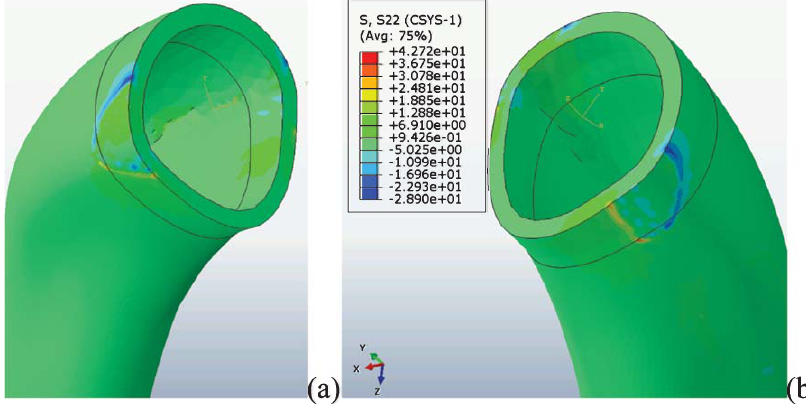
Fig. 12. (a) Right view and (b) left view of the circumferential stress (MPa) distribution in the cement mantle.